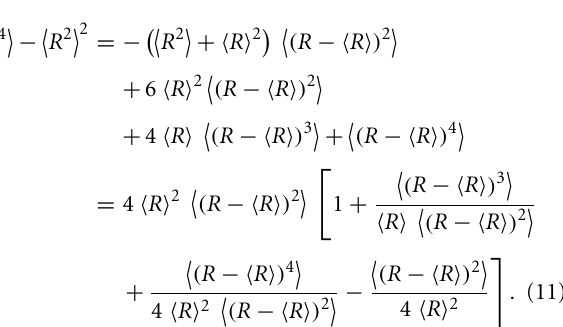
curve). The time increments between successive curves of the same color correspond to a time lapse resulting in an increase of the total aggregate volume by a factor of 10 1 / 5 . Consequently, the rightmost curves of each color correspond to systems where the total aggregate volume grew by a factor of hundred. In the main text we discuss the similarities and differences between the CDFs in each of the resulting quadruplets. This allows us to pinpoint salient features of the impact of k on the time evolution of the